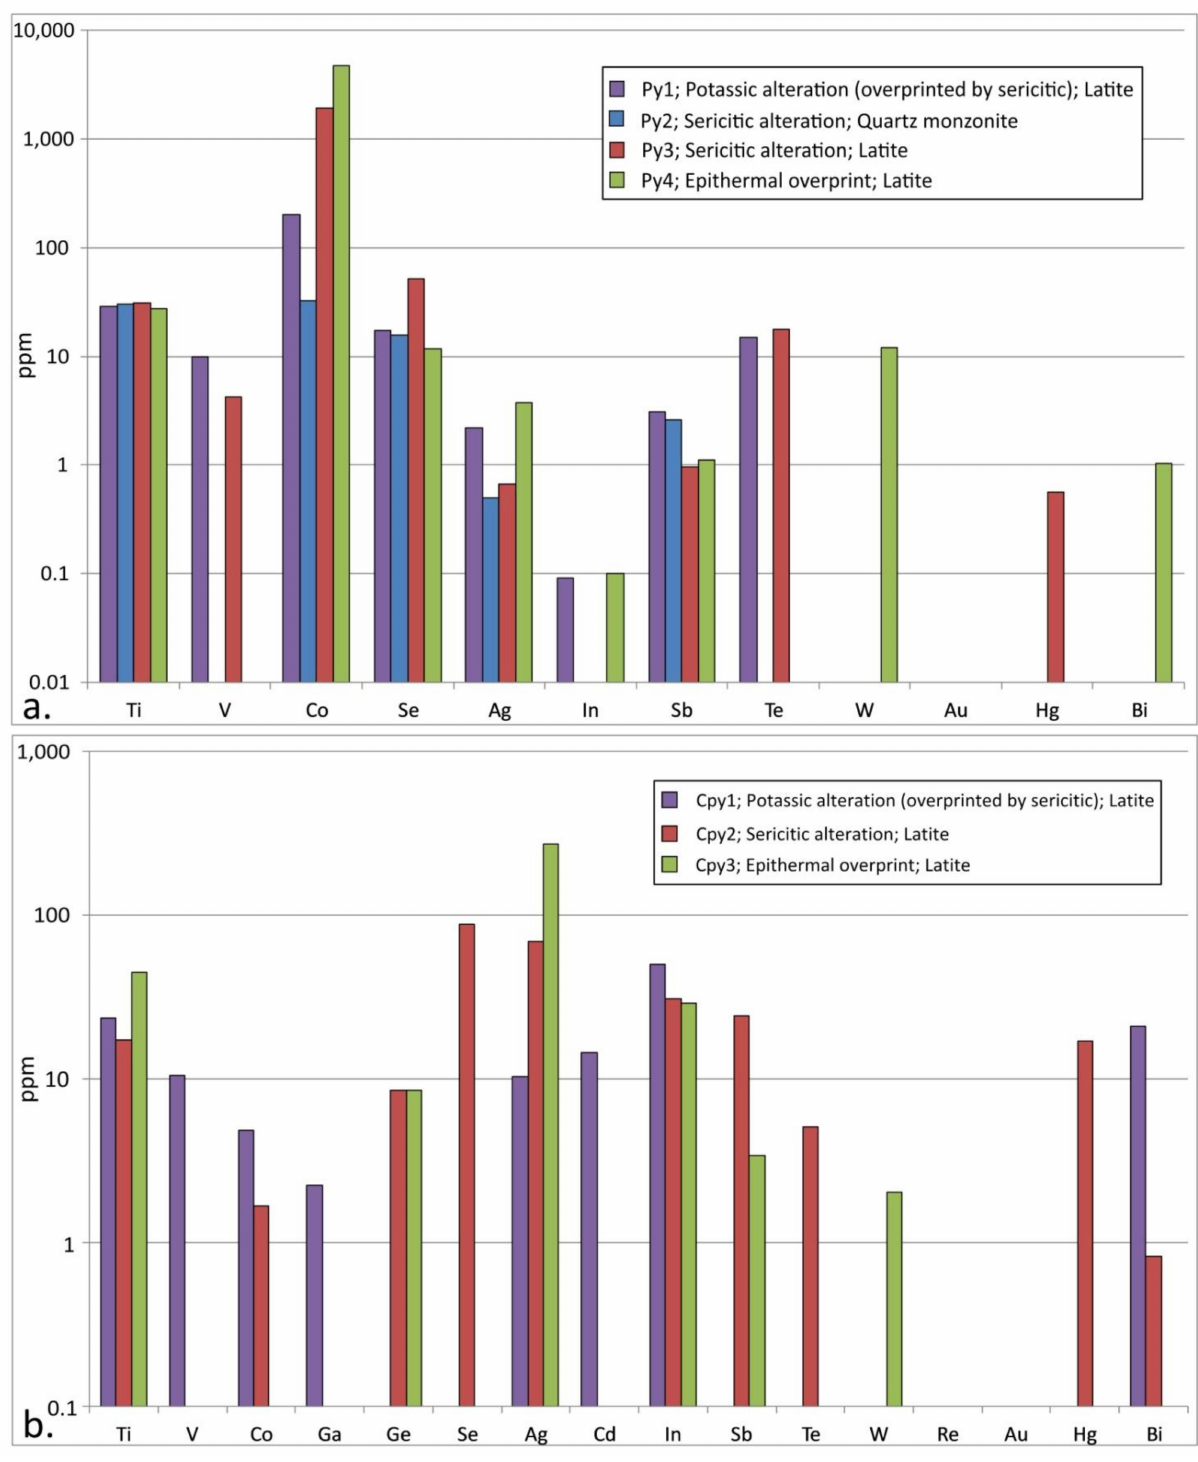
Figure 9. Average values of rare metal concentrations of ( a ) pyrite and ( b ) chalcopyrite from various mineralization stages. Values are in ppm. Local enrichments related to nano-scale mineral inclusions are